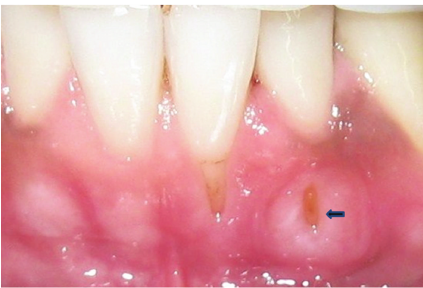
Figure 2: Partial thickness tunnel connecting two vertical incisions for fenestration coverage.